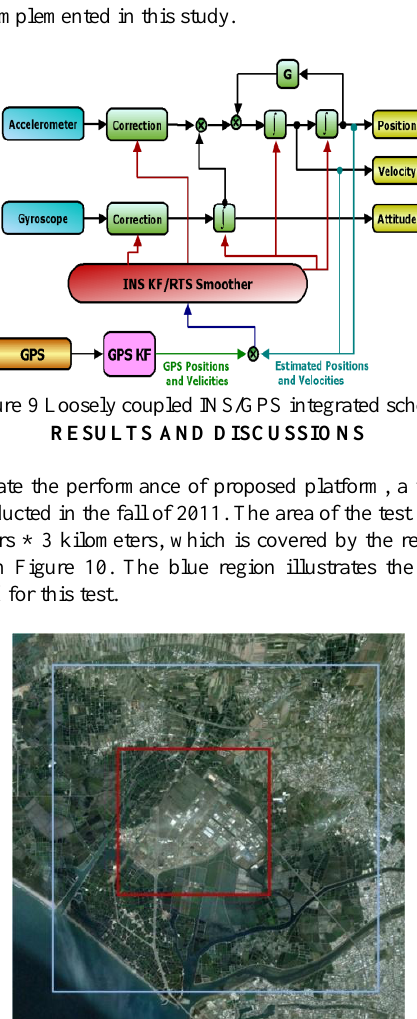
Figure 10 Proposed DG-ready photogrammetric procedure Flight planning